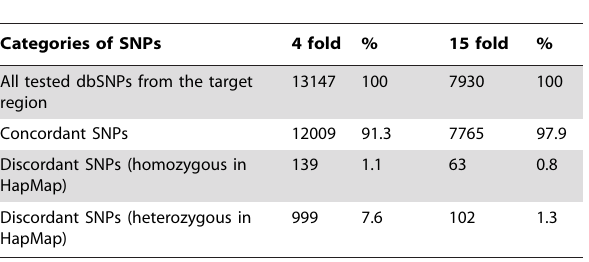
Table 3. Comparison of SNPs recovered in this study using different thresholds of sequence coverage (4- and 15-fold) with HapMap SNPs.